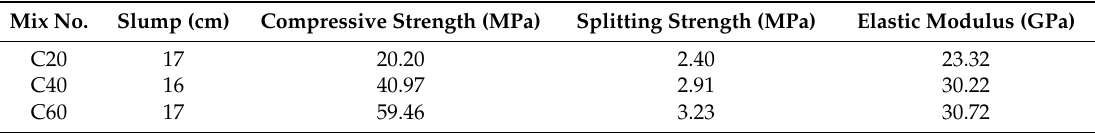
Table 5. Mechanical properties of